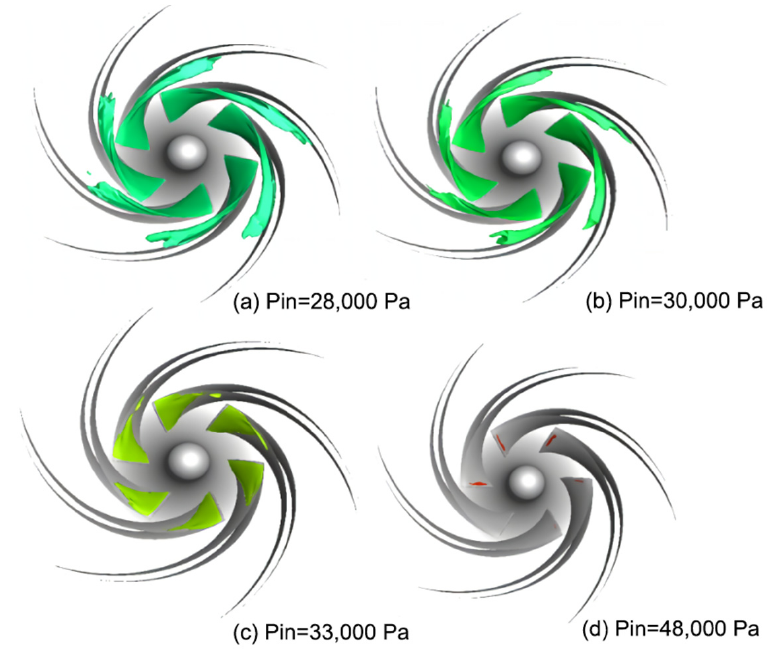
Figure 9. Morphology of vacuoles under different NPSHs.